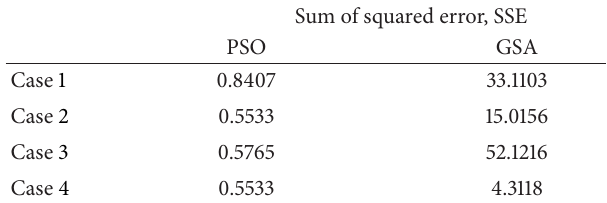
Table 3: SSE obtained from combination of backstepping with PSO and